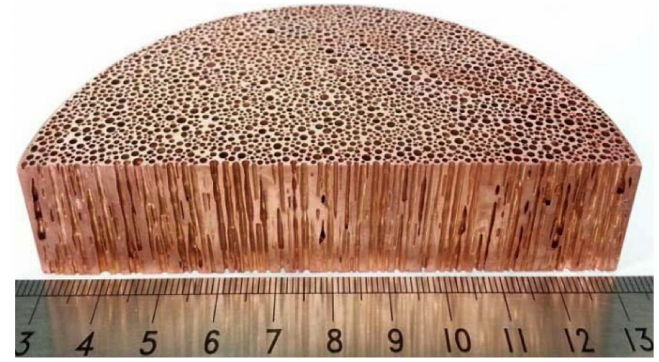
Figure 1. Section of a lotus-type porous copper ingot. Reproduced from [2], with permission from Elsevier,